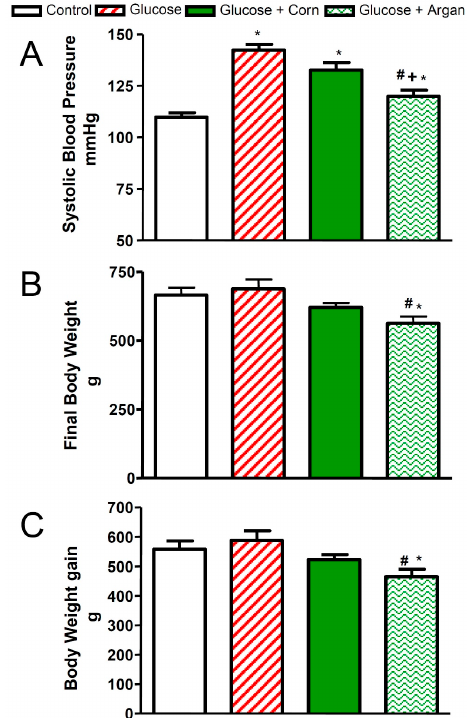
Figure 1. Effects of 12 weeks of glucose feeding combined or not with orally and daily administered (5 mL·kg − 1 ) corn oil or argan oil on ( A ) systolic blood pressure expressed in mmHg, ( B ) final body weight expressed in g and ( C ) body weight gain expressed in g. Values are the mean ± SEM of 8–10 rats per group. * p < 0.05 vs. control, # p < 0.05 vs. glucose, + p < 0.05 vs. glucose + corn oil.